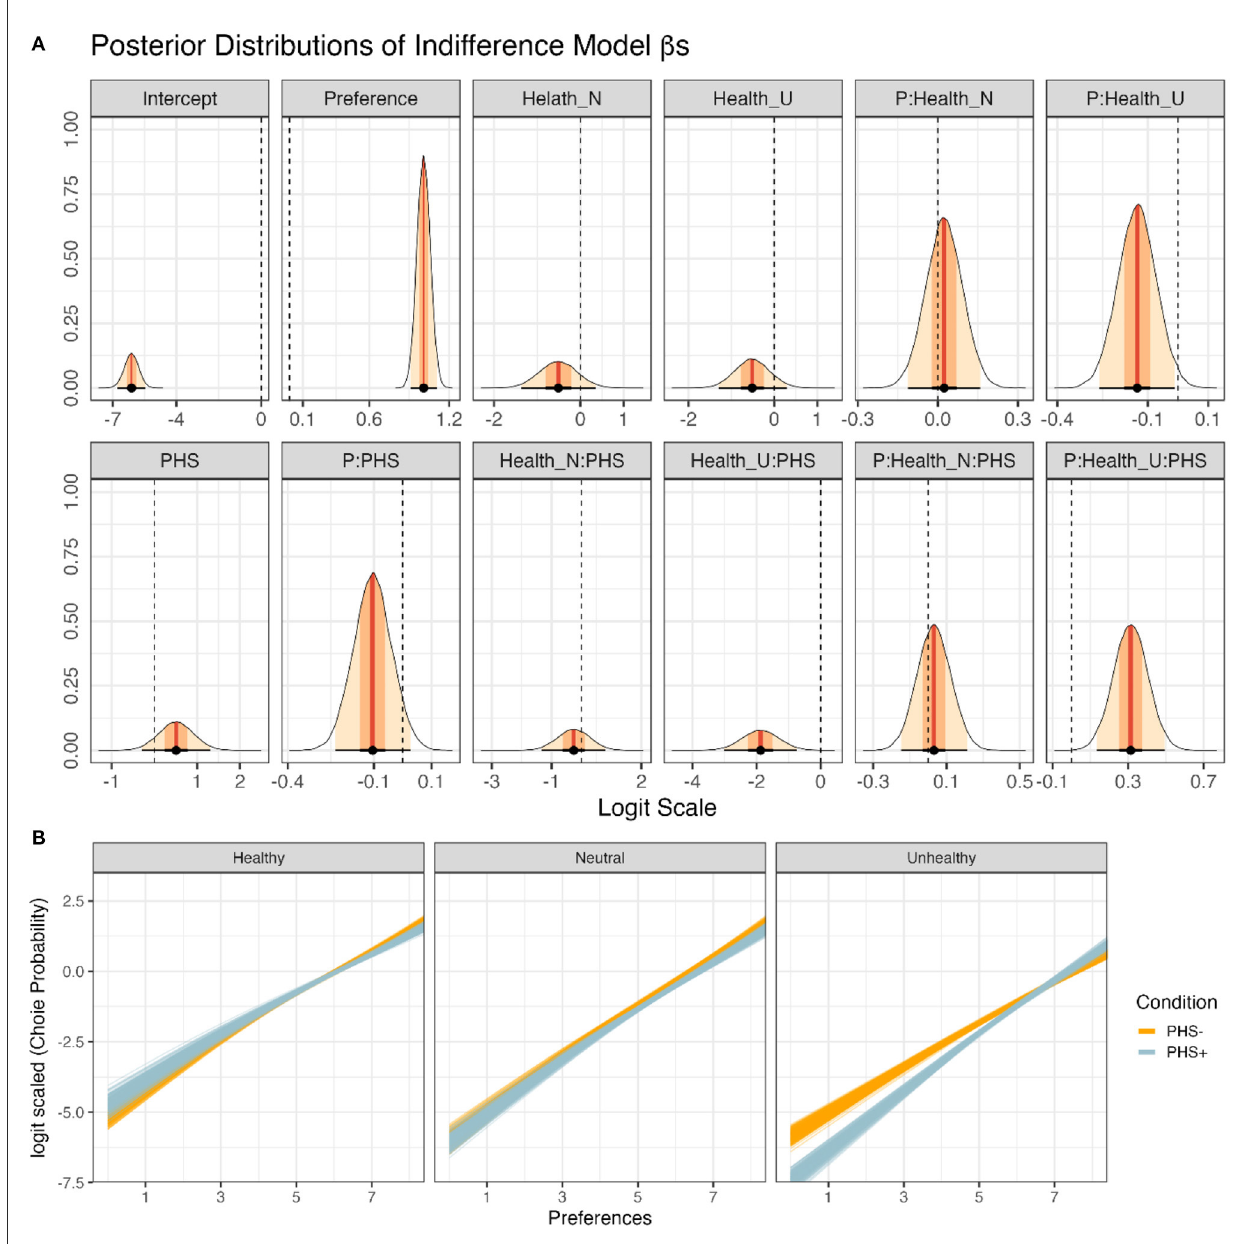
FIGURE7 Modeling of the relationship between choices, as measured by the online supermarket task, and preferences, as measured by the subjective rating task. (A) Posterior distributions of all β -coefficients included in the full Preference Model, except those containing Session or its interactions (Equation 6). Red lines and orange and yellow shadows represent the mean point estimates and the 50 and 95% highest probability density (HPD) areas, respectively. Please note the different scalings of the X-axes. (B) The posterior predictions for specific hypotheses. For more details regarding the hypotheses and results, see the text. Each line presents a posterior prediction; in total, 200 predictions are